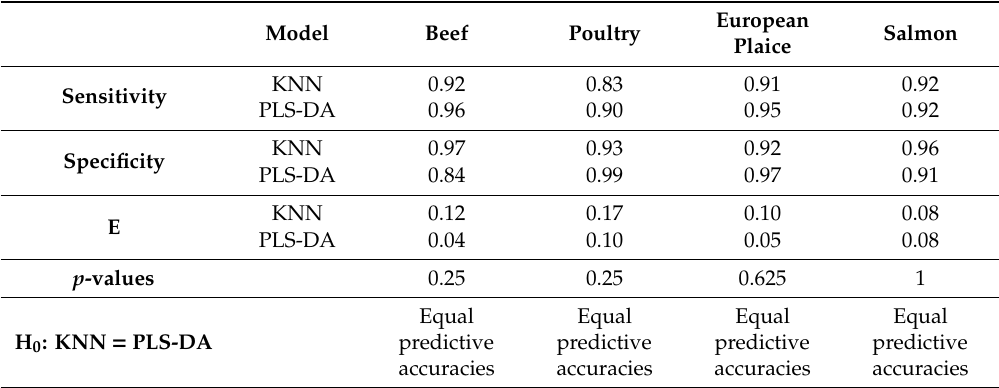
Table 9. Prediction results of K-NN and PLS-DA models for beef, poultry, European plaice, and salmon in term of weighted Sensitivity (%) and weighted Specificity (%) and their comparison by McNemar’s